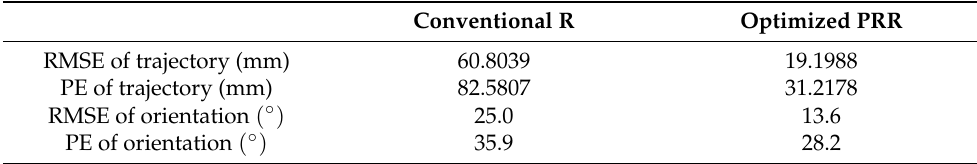
Table 4. Actual trajectory and orientation error during additional work-related